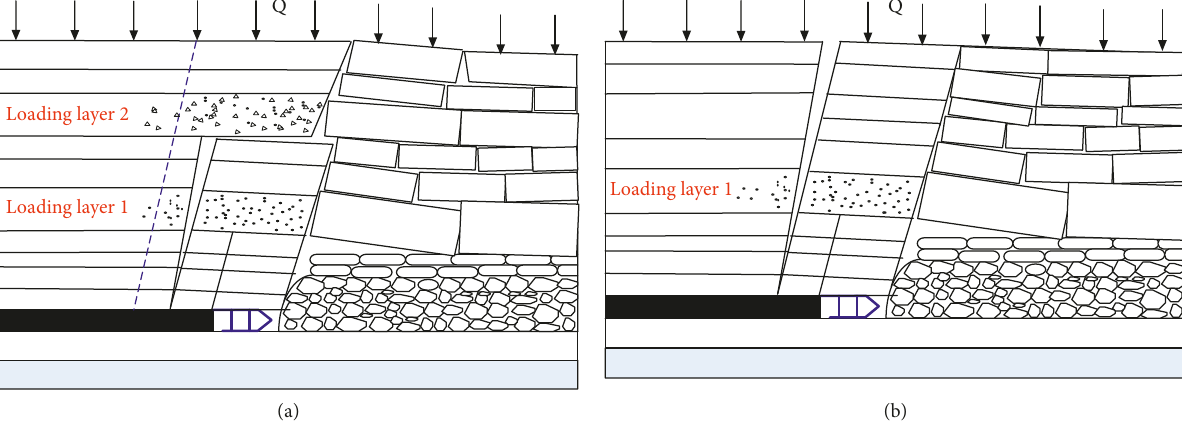
Figure 7: Working face hydraulic support that surround the rock relations: (a) double and (b) single bearing layer